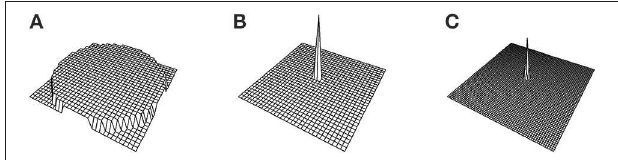
FIGURE 2 | If we lay a grid over a finite landscape, we can calculate for each grid square the probability that a dance has pointed to it. In (A) we see depicted the prior probability assuming equal probability for each square within a 14km radius. In (B,C) we depict the probabilities after a dance has been observed for 1750 and 875m grid square length, respectively. This corresponds to the 3rd and 4th iteration in Figure 3